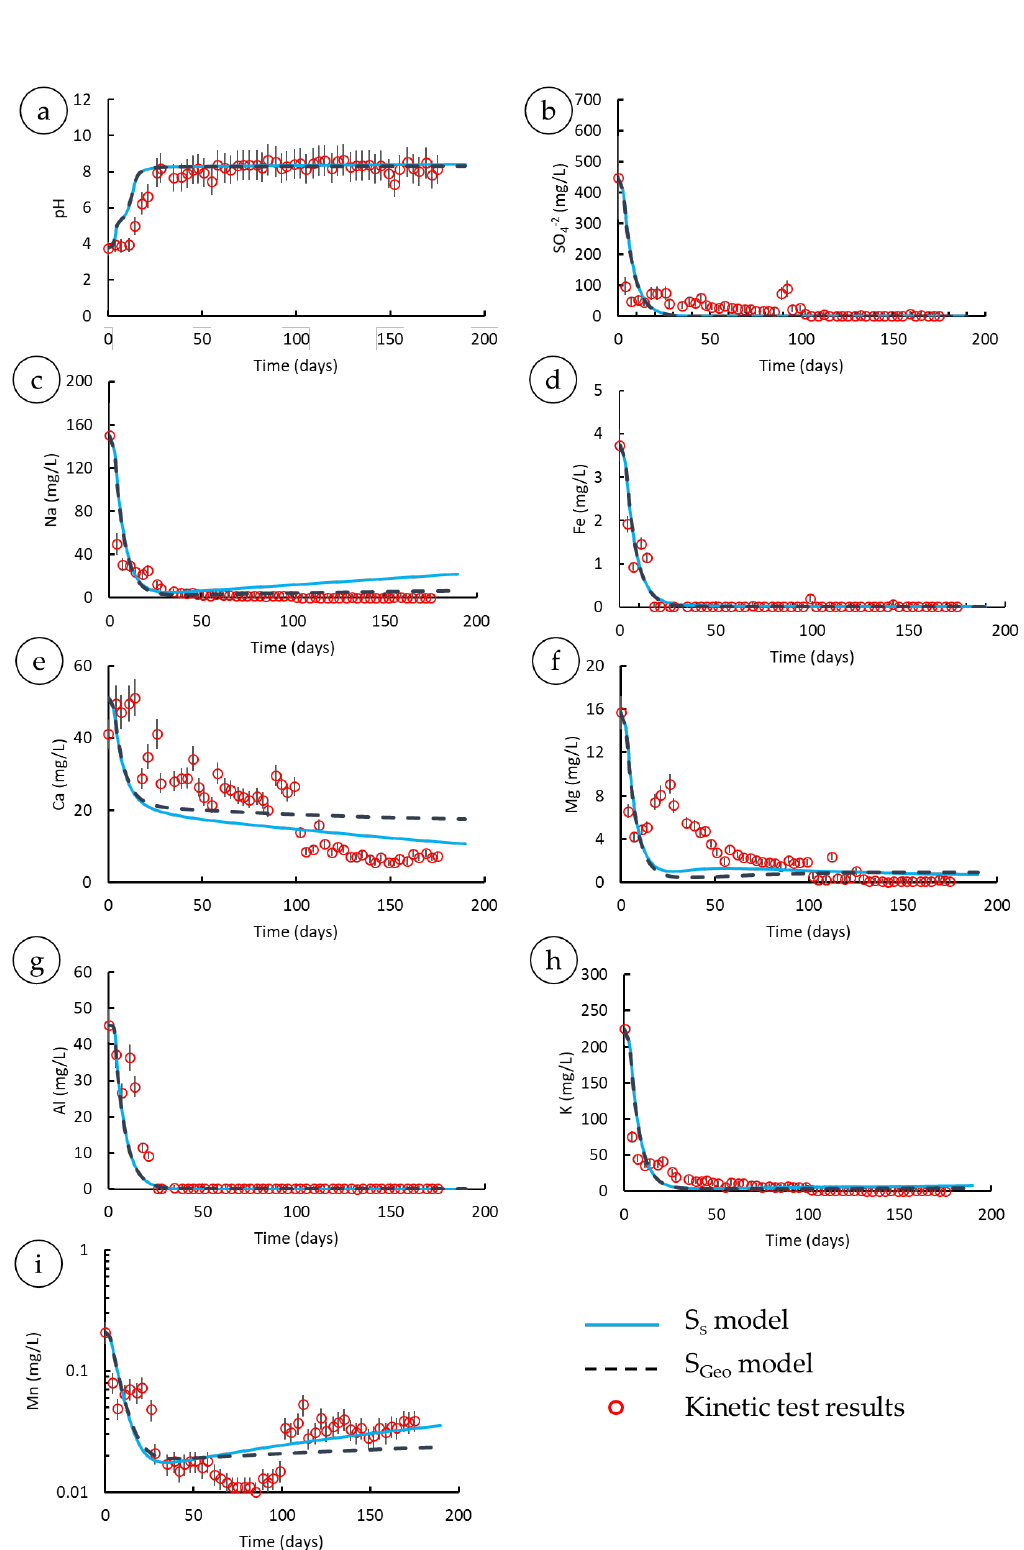
Figure 5. Weathering cell test D2 and PHREEQC modeling results using BET and geometric surface area-derived rates. ( a ) Experimental and simulated results of the pH. ( b ) Experimental and simulated results of sulfate. ( c ) Experimental and simulated results of sodium. ( d ) Experimental and simulated results of the total dissolved iron. ( e ) Experimental and simulated results of total dissolved calcium. ( f ) Experimental and simulated results of total dissolved magnesium. ( g ) Experimental and simulated results of total dissolved aluminum. ( h ) Experimental and simulated results of total dissolved potassium. ( i ) Experimental and simulated results of total dissolved manganese.